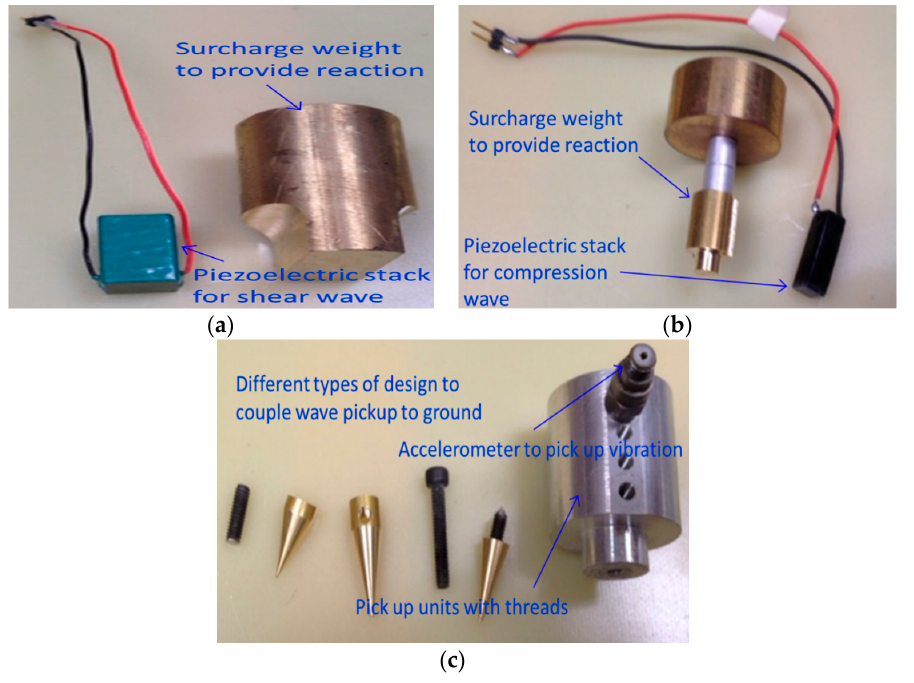
Figure 12. Composition of Piezoelectric Stack. ( a ) Piezoelectric Stack for shear wave and weight; ( b ) Piezoelectric Stack for compression wave and weight; ( c ) Accelerometer to pick up vibration. Table 2. Characteristics of the Piezoelectric Stack [29].